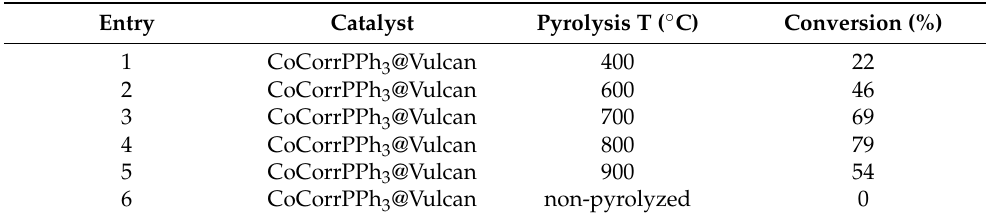
Table 3. Hydrogenation of nitrobenzene; optimization of the pyrolysis temperature. Reaction conditions: nitrobenzene (0.25 mmol), CoCorrPPh 3 @Vulcan-X (0.5 mol%), H 2 (40 bar), MeOH (2 mL),